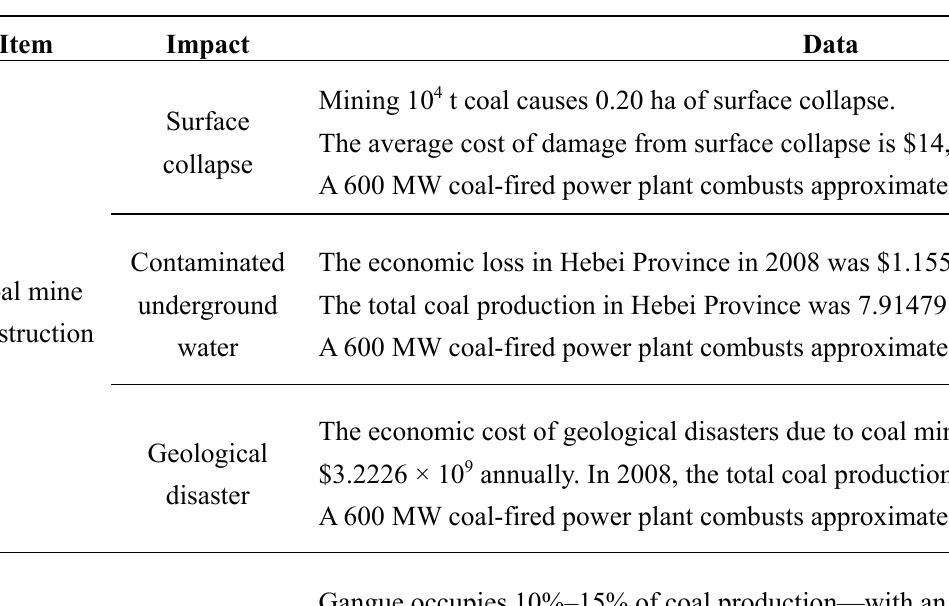
Table 3. External costs of coal power